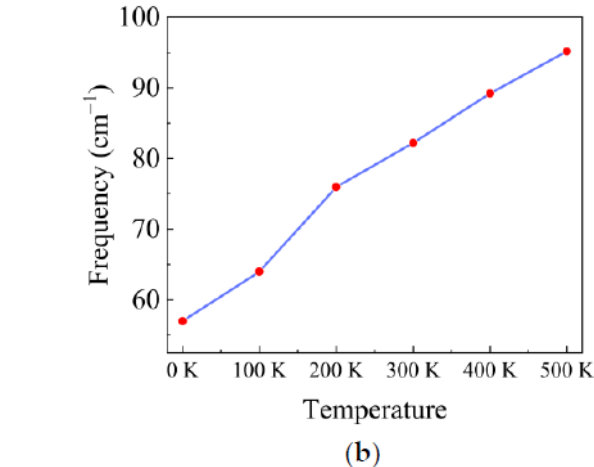
Figure 3. ( a ) The dispersion of TA branches with increasing temperature. ( b ) The frequency of the main peak of the VDOS with increasing temperature. Every point corresponds to the frequency of TA branches’ shoulder at M (0.5,0.5,0).